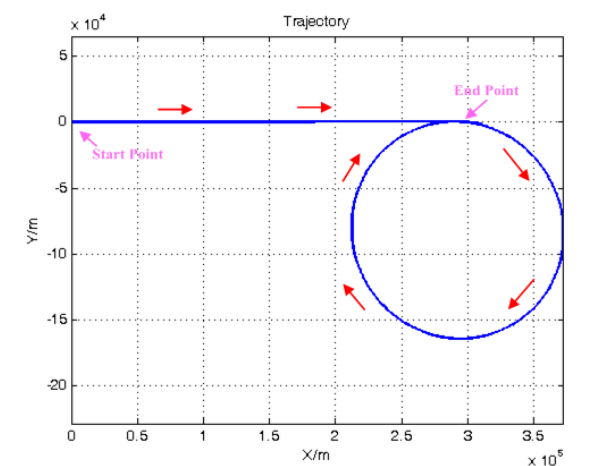
Figure 7. Simulated trajectory.